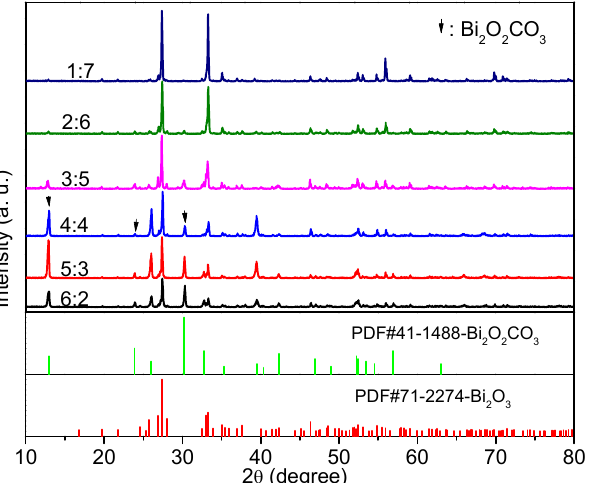
Figure 2. XRD patterns of the samples prepared at 140 °C for 10 h in the ethylenediamine–water mixture with various ratios of V en :V water .